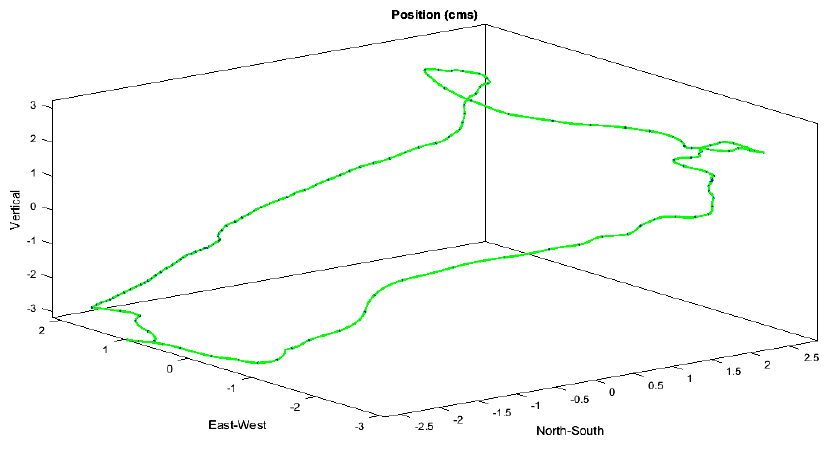
Figure 9. Dragonfly algorithm used for routing different ranges of temperature.